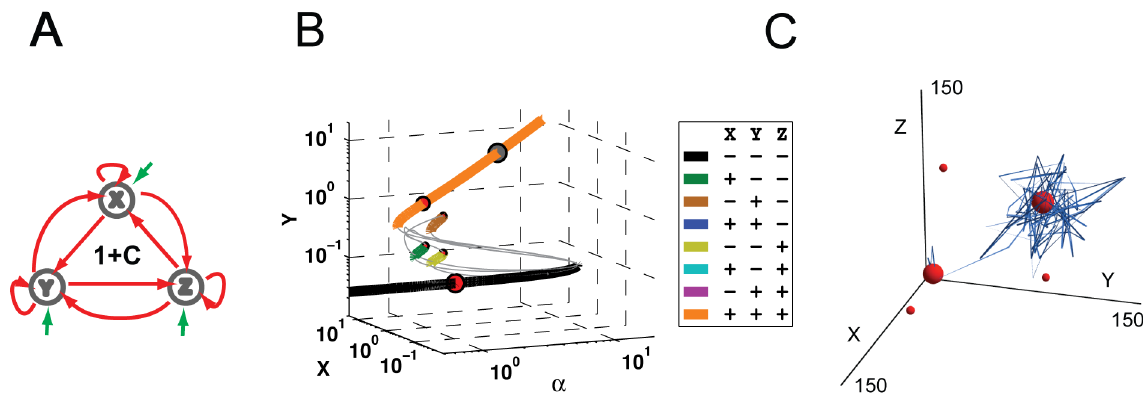
Figure 7. Bifurcation and Stochastic Analysis of Network 1 with constitutive basal expression. (A) The topology of Network 1 is used to mimic iPSC experiments with added constitutive expression of all three genes. (B) As in Figure 5B, the X and Y protein concentrations of stable and unstable steady states are plotted against self-activation strengths. With the addition of the constitutive expression we can see a further decrease in stabilities, specifically two-ON states are never stable. Additionally one-ON states lose stability very rapidly, approximately at a =1, and the all-OFF state destabilizes after a =9 leaving only the all-ON state. This can also be seen in the sizes of the spectral radii, deterministically these steady states exist but in practice they have very little influence. (C) Simulations of Network 1 modeled in the presence of an additional constitutive overexpression term consistently show a transition from an all-OFF state to an all-ON state after a period of latency. orange all-ON and black all-OFF lines) possessed considerably higher stabilities than the others (Figure 7B). All one-ON-two- OFF SSS (green, brown, and yellow lines) are only stable for a narrow range of a . Even when they are stable, their stabilities are insignificant. Looking closely we can see that between the red, green, and yellow lines there are 3 unstable paths without a stable component. These lines would be the locations of two-ON-one- OFF states if they achieved stability. More importantly, as auto- activation strengthens, even the all-OFF state’s stability becomes insignificant when compared with the all-ON state (Figure 7B gray circles).